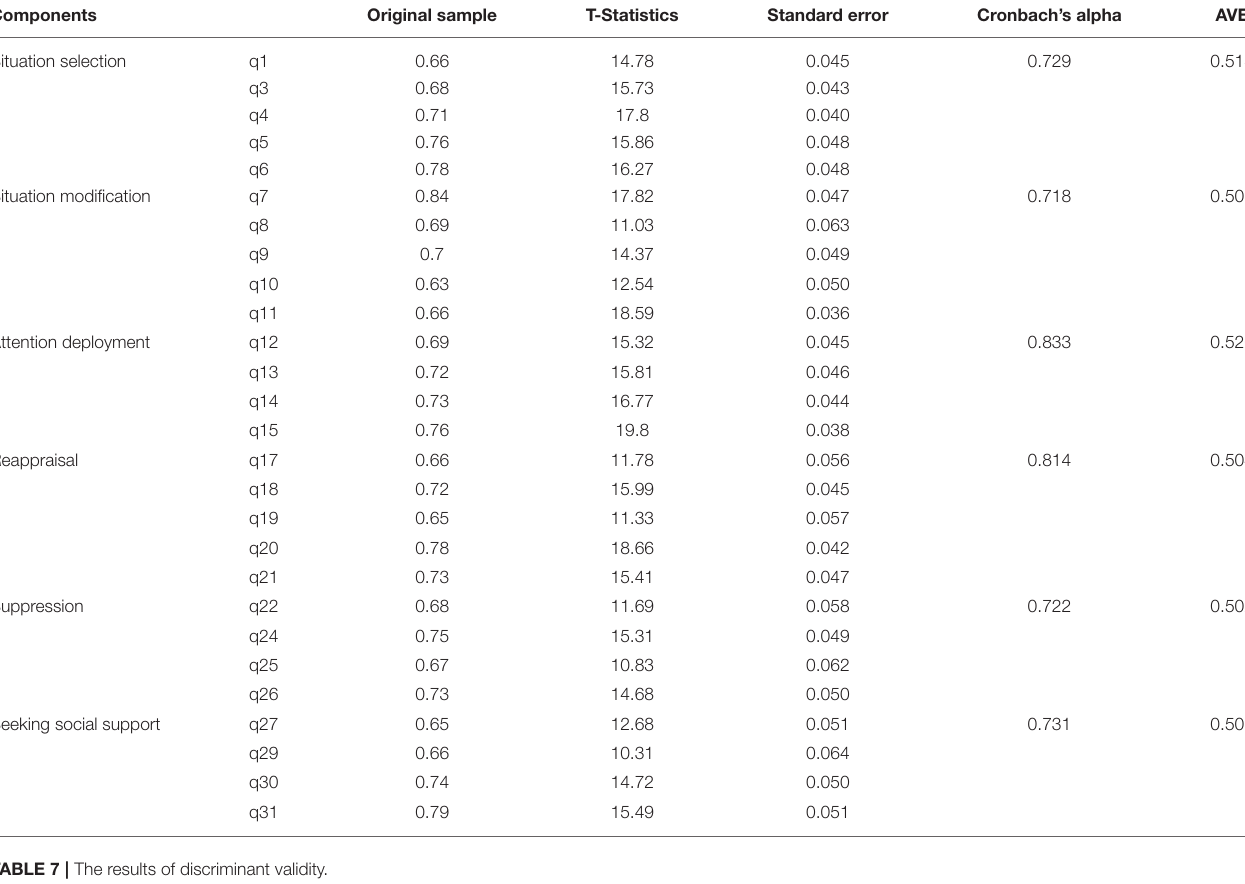
TABLE 6 | The results of confirmatory factor analysis and Cronbach’s alpha (the second model).